Question: Describe this figure in one sentence.
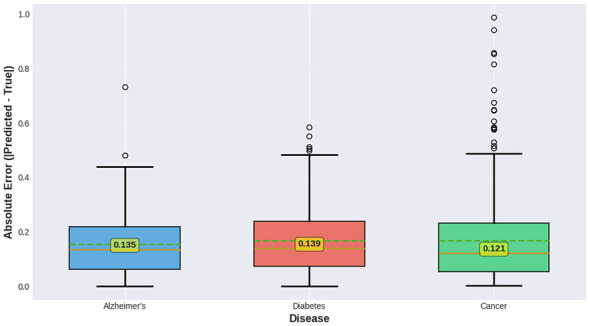
Answer: Absolute error distribution across diseases.